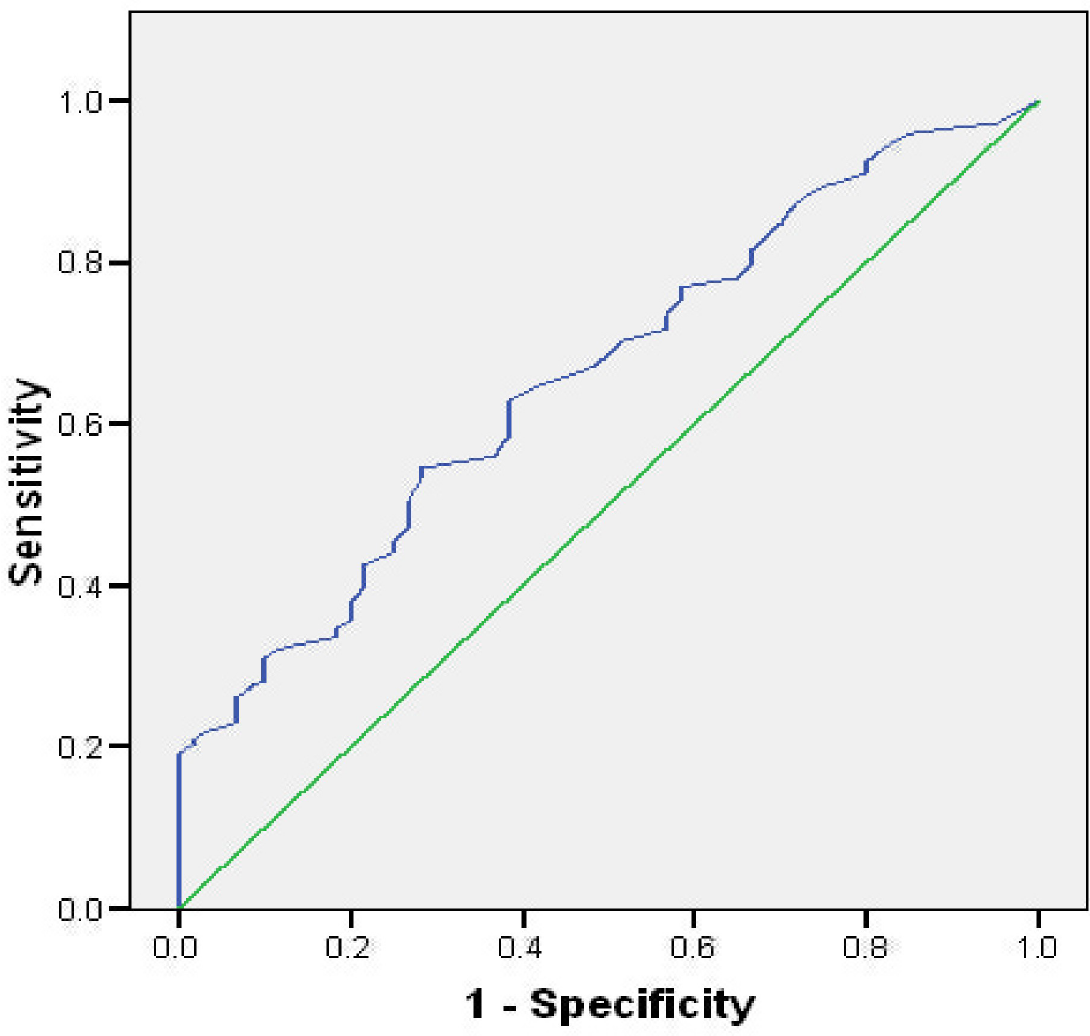
Fig 2. ROC analysis of COVID Stress Scales according to Perceived Stress